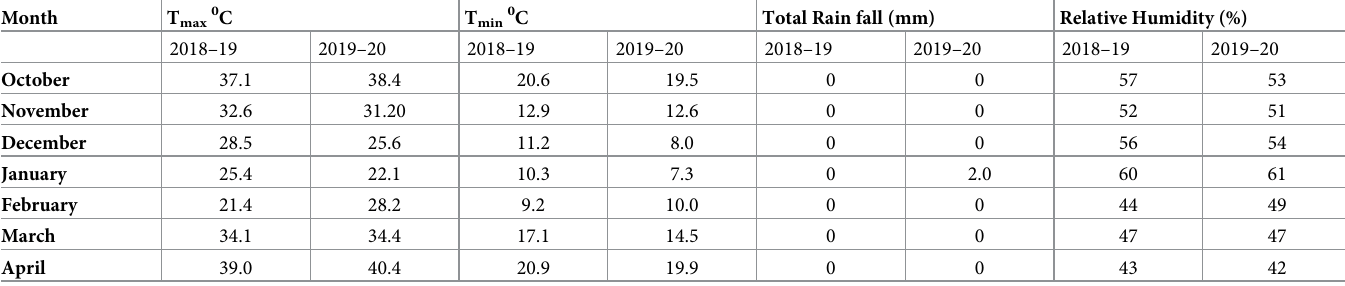
Table 1. Weather data of experimental location during